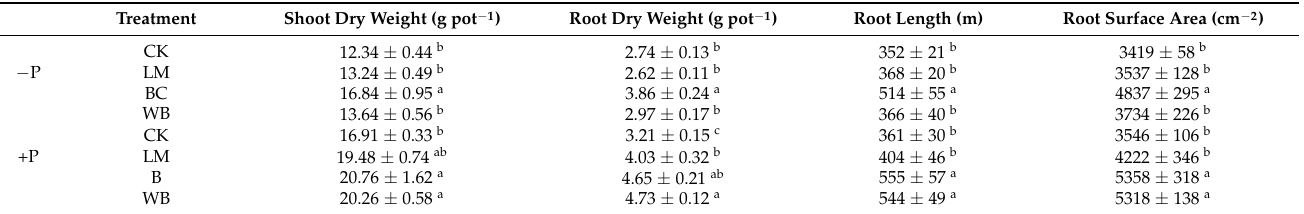
Table 5. Effect of biochar and P supply on the growth and root morphology of rice ( Oryza sativa L.) seedlings.